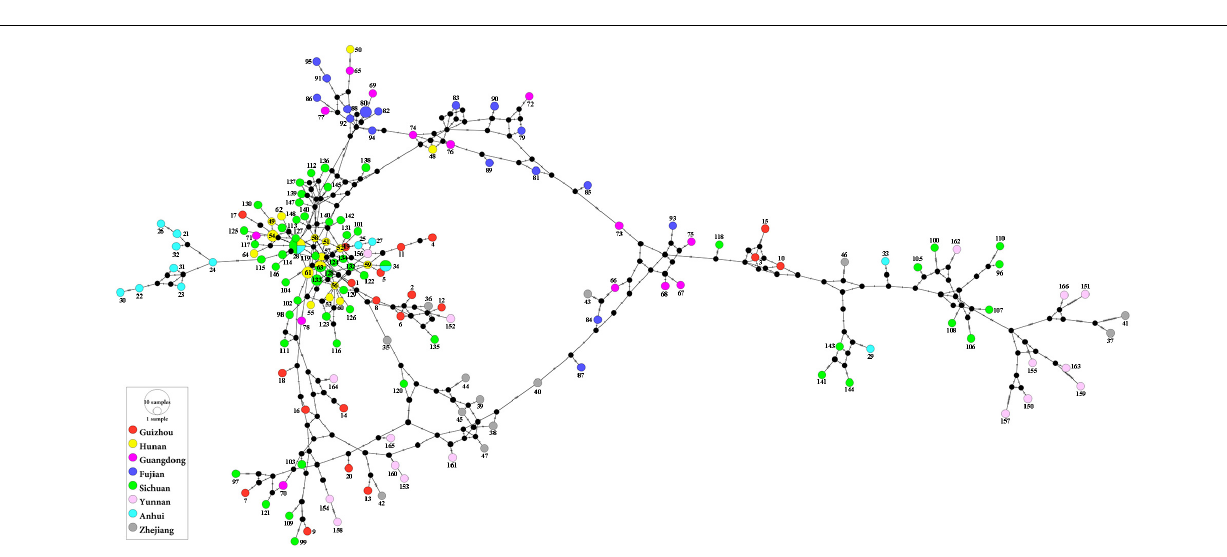
Frontiers in Ecology and Evolution |